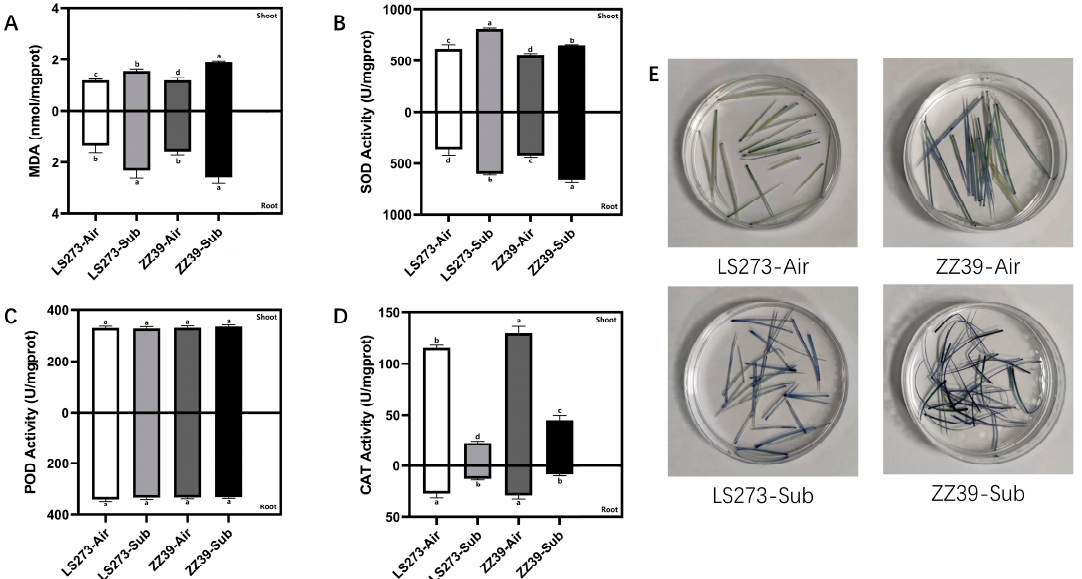
Figure 2. Results of antioxidative enzymes and TB staining. ( A ) MDA content; ( B ) SOD activity; ( C ) POD activity; ( D ) CAT activity; ( E ) TB staining results. Columns with the same letter are not significantly different at p < 0.05, one-way ANOVA, followed by Tukey’s honest significant difference and other tests.